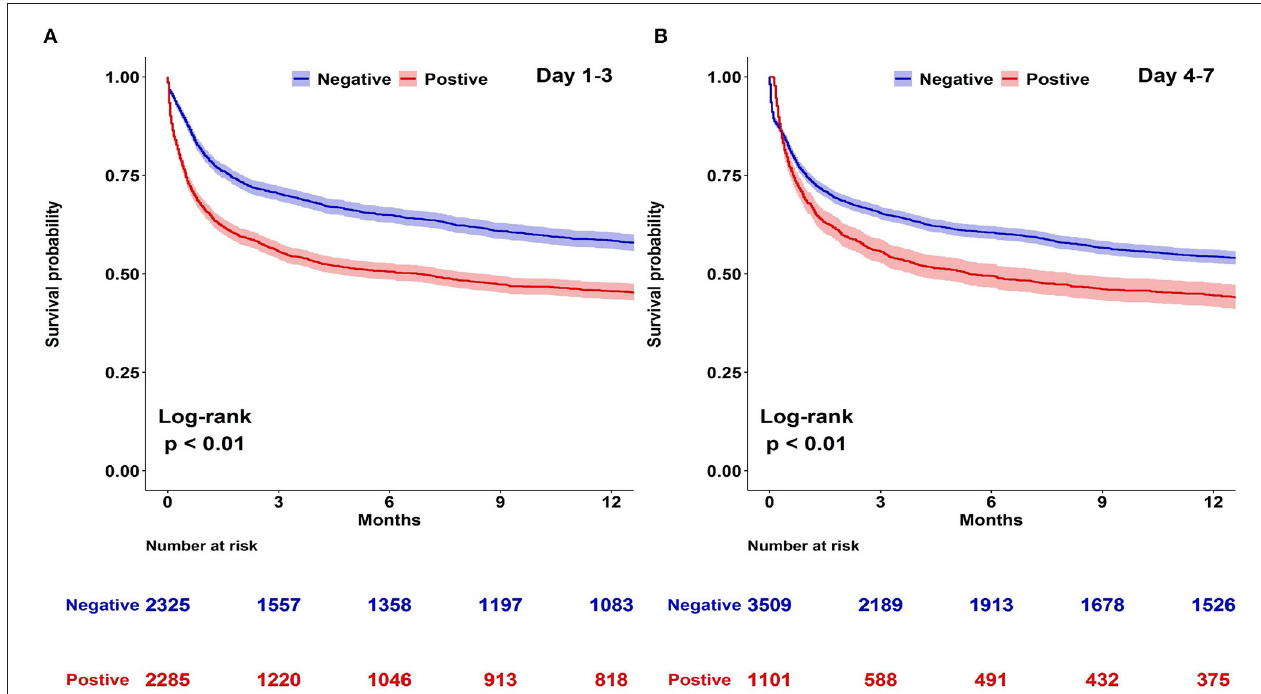
FIGURE 2 | Kaplan–Meier survival curves stratified by day 1–3 or day 4–7 cumulative fluid balance (CFB). Kaplan–Meier curves for long-term survival stratified by day 1–3 or day 4–7 CFB with log-rank test model among 4,610 patients admitted to medical intensive care units. (A) Day 1–3 CFB: negative vs. positive. (B) Day 4–7 CFB: negative vs.